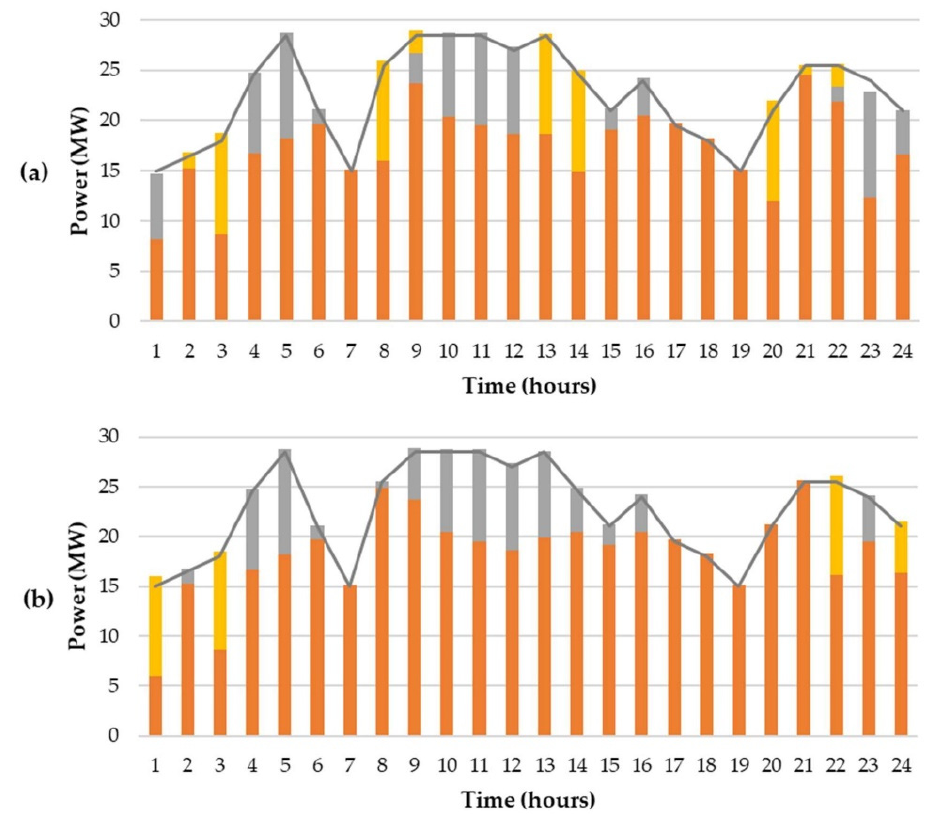
Figure 9. The ESS operational scheduling with scenario 𝑝 (cid:2869) of the reserve probability: ( a ) The reserve bid is called on to produce; ( b ) the reserve bid is not called on to produce